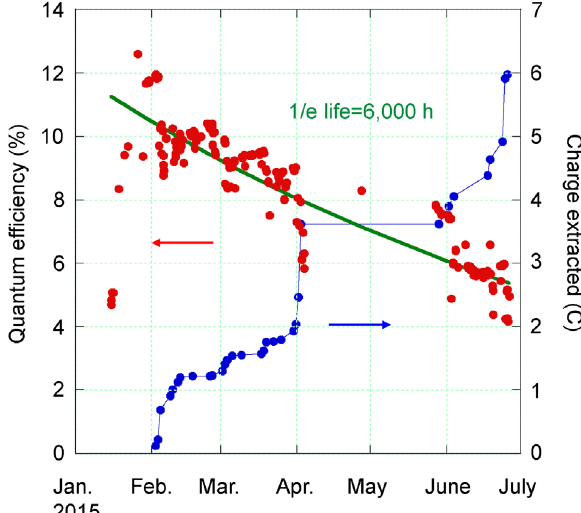
FIG. 3. Quantum efficiency of GaAs photocathode (red circle) and charge (blue circle) extracted during the low current cERL commissioning from January to July in 2015.